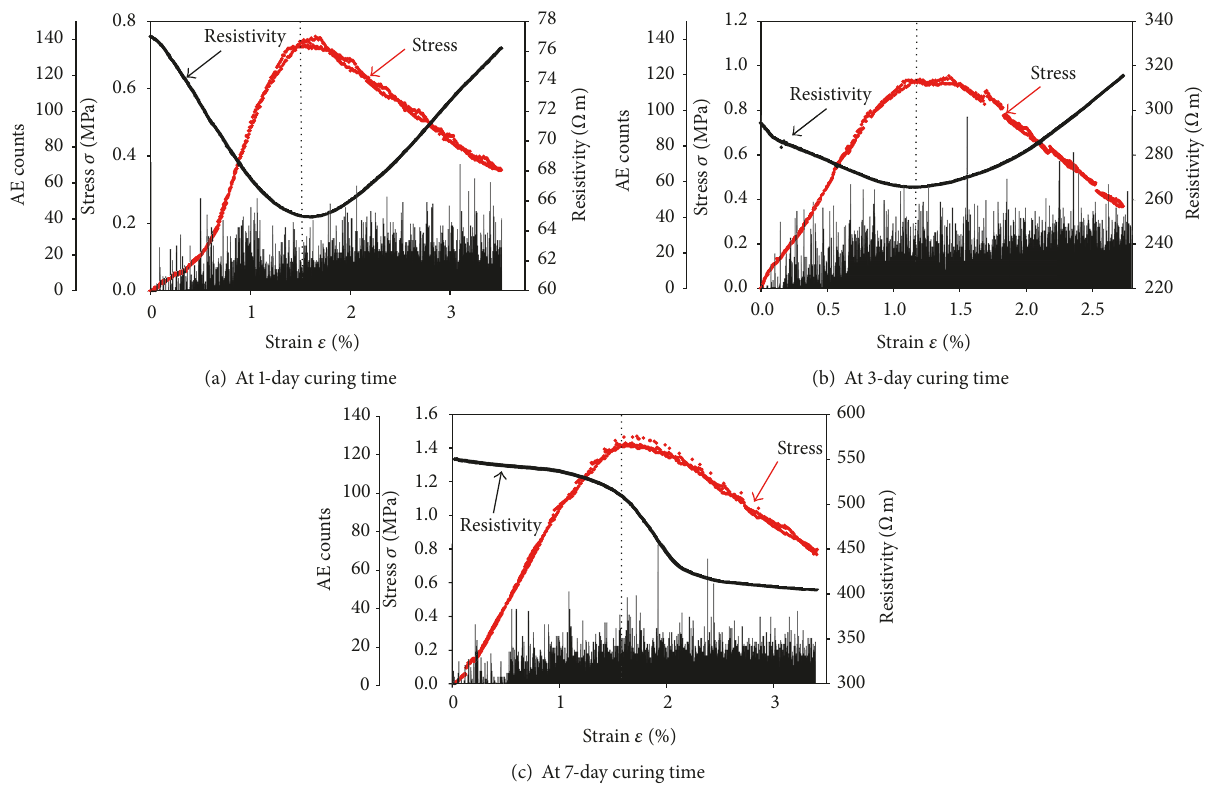
Figure 8: Relational graph of CGB stress, resistivity, and AE